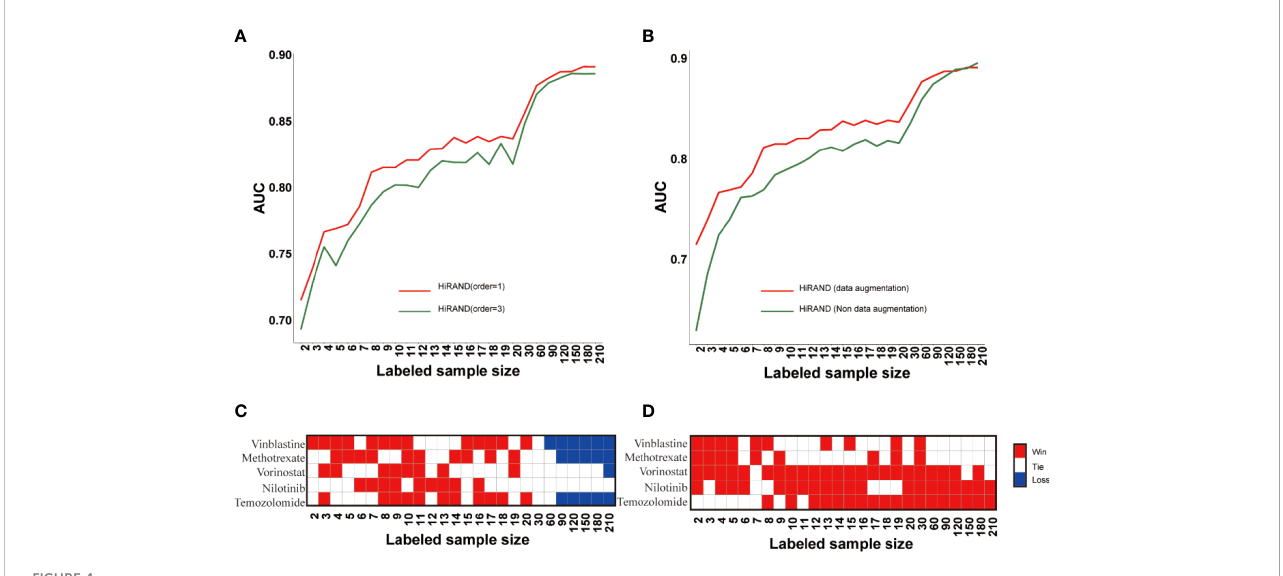
FIGURE 4 The ablation studies for examining the contributions of different components in HiRAND. (A) The AUC comparison of different convolution step lengths; red line and blue line represented the one step and three steps, respectively. (B) The AUC comparison of data augmentation; red line and green line represented the training with and without data augmentation. The contrast results of HiRAND and (C) HiGCN and (D) Af fi nityNet across fi ve drugs. Red, white, and blue represented HiRAND win, tie, and loss in the comparison,